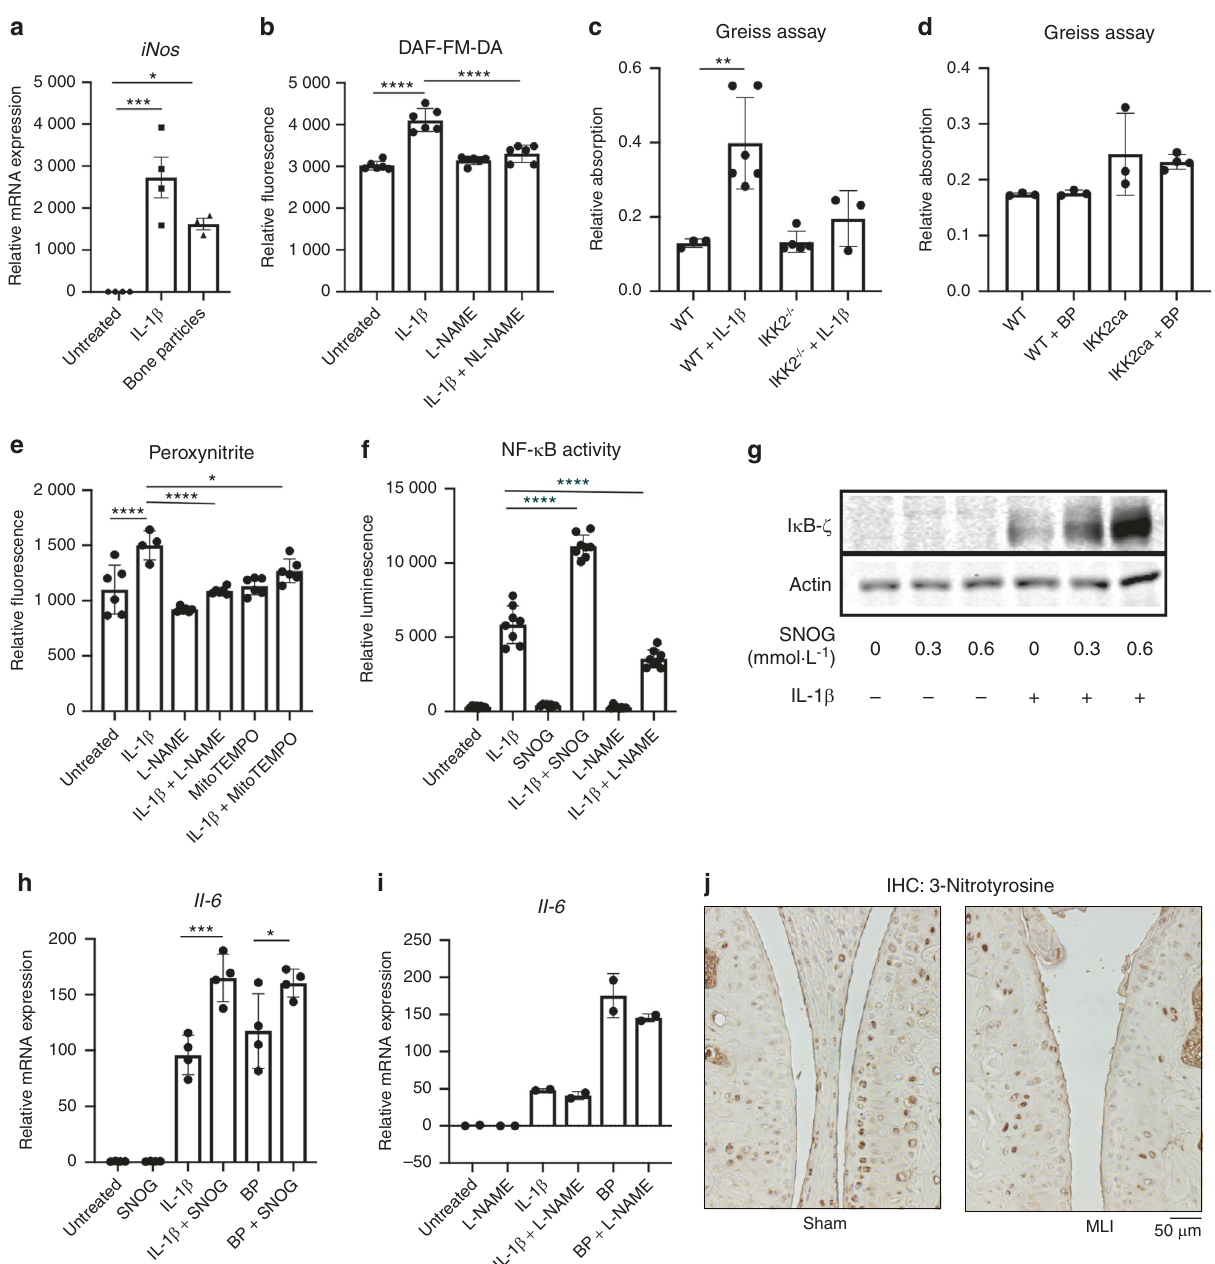
Fig. 8 Nitrosative stress has different effects on in fl ammatory response in vitro and in vivo. a Chondrocytes were treated with IL-1 β or BP for 24 h. Gene expression of iNos was measured by qPCR (F: Untreated vs IL-1 β *** P = 0.000 6, Untreated vs BP * P = 0.020 1). b Chondrocytes were treated with IL-1 β ± L-NAME (75 μ mol·L − 1 ) for 24 h. NO levels were measured using DAF-FM-DA fl uorescent probe. Bars represent mean ± SD of n = 8 replicates from representative experiment (**** P < 0.000 1). c WT or IKK2 − / − chondrocytes were treated with IL-1 β for 24 h. Supernatant was collected and Greiss assay was carried out to measure NO production. (WT vs WT + IL-1 β ** P = 0.002 6). Results are representative of at least 3 biological replicates. d Chondrocytes were transduced with pMX-GFP (WT) or pMX-IKK2ca. They were then treated with BP for 24 h. Supernatant was collected and NO production was performed using Greiss assay. Results are representative of at least three biological replicates. e Chondrocytes treated with IL-1 β ± L-NAME (75 μ mol·L − 1 ) or MitoTEMPO (0.5 mmol·L − 1 ) for 24 h. Peroxynitrite